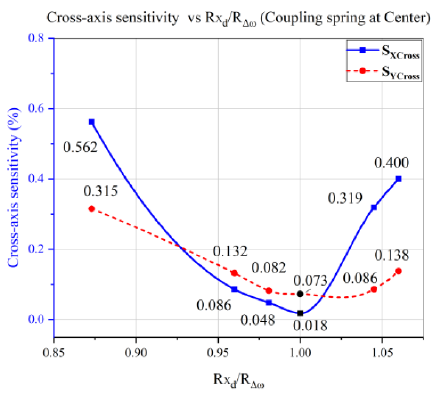
/𝑅 ∆ Analysis of the Single-Drive Multi-Axis 𝝎 𝒅